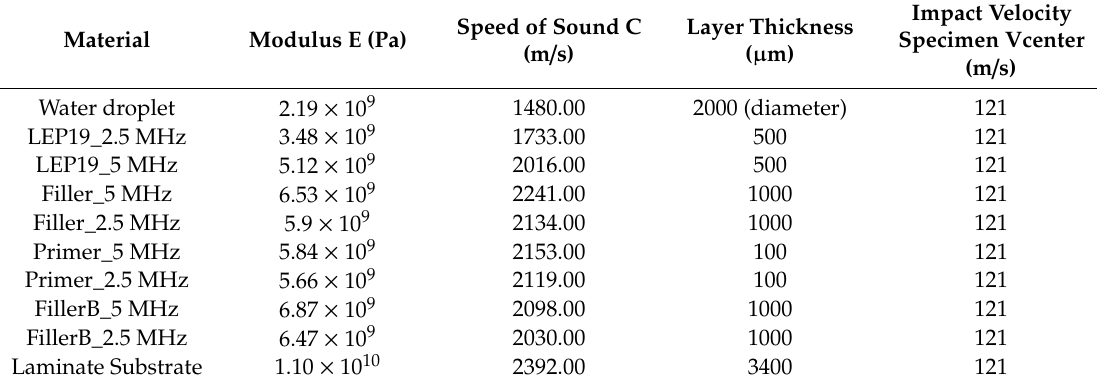
Table 2. Reference Input data used for the Lifetime Springer modelling in Case2.